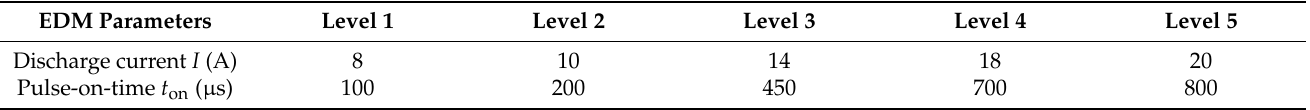
Table 4. Levels of parameters for Hartley